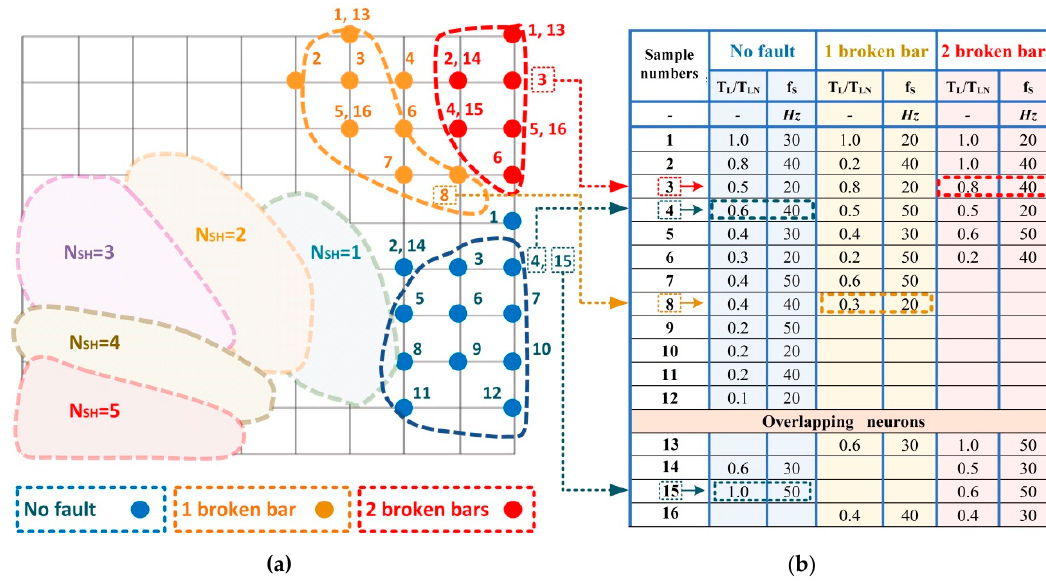
Figure 12. Classification of the rotor cage damage of the induction motor: ( a ) Kohonen map 10 × 10: dotted lines—IM damage categories involved in the classification, hatched areas—IM damage categories not involved in the classification; ( b ) specification of test data parameters; T L —load torque, T LN —rated motor torque, f s —frequency of the supply voltage, N sh —number of shorted turns in the stator winding. IM: induction motor.